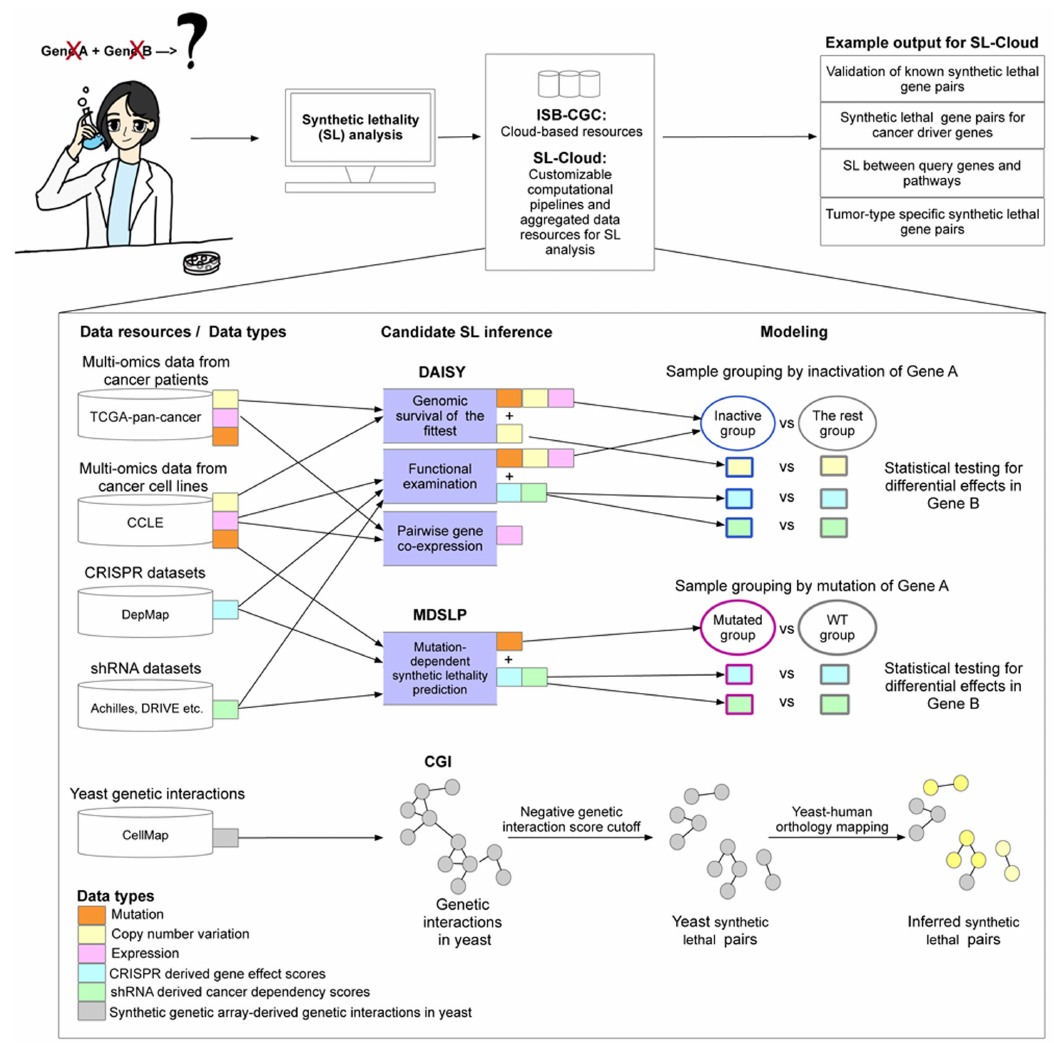
Figure 1. Overview of the Synthetic Lethality Cloud (SL-Cloud) framework. Schematic overview of the computational workflows and data resources aggregated in this framework to facilitate investigation of synthetic lethal interactions. Users with specific research questions (top-left) reuse inference workflows from the provided scientific computing notebooks to query public cancer genomics datasets from the vast resources provided by the ISB-CGC and additional datasets pre-processed in SL-Cloud. Three candidate synthetic lethal pair inference workflows were implemented, including the DAta-minIng SYnthetic lethality identification (DAISY), mutation-dependent synthetic lethality prediction (MDSLP), and conserved genetic interaction (CGI) workflows. Different data resources and data types were used for different inference workflows. For example, the DAISY and MDSLP workflows rely on statistical testing over the multiple omics data and functional screening data such as CRISPR and shRNA datasets for human cancers, whereas the CGI workflow is based on an ortholog mapping of the SL interactions identified in